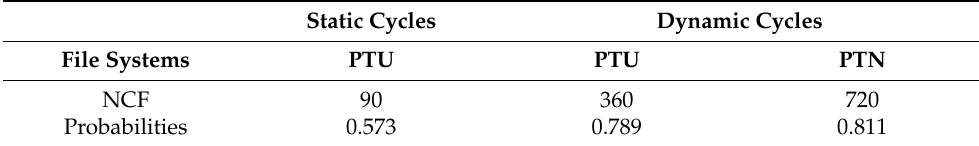
Table 4. Survival probabilities of experimental file systems.